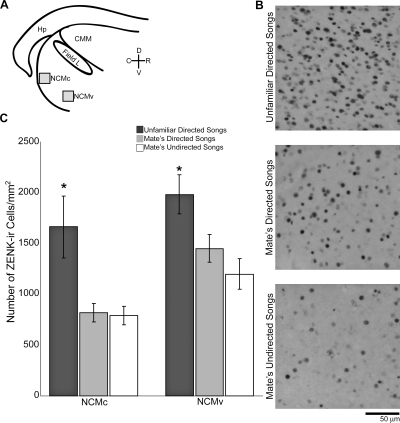
The Number of ZENK-Expressing Cells in the NCM Is Preferentially Increased by Unfamiliar Stimuli(A) Diagram of the regions sampled within NCM. HP, hippocampus; NCMc, caudal region of NCM; NCMv, ventral region of NCM. Both regions were similar to those used in ZENK cell counts in NCM in other studies (see Methods).(B) Representative images of ZENK staining in NCM (caudal region) in each of the stimulus groups.(C) Mean number of cells per area in the caudal and ventral regions of the NCM. Females that heard unfamiliar directed songs had significantly more ZENK-expressing cells than females that heard their mate's directed or undirected songs. (*p < 0.05).